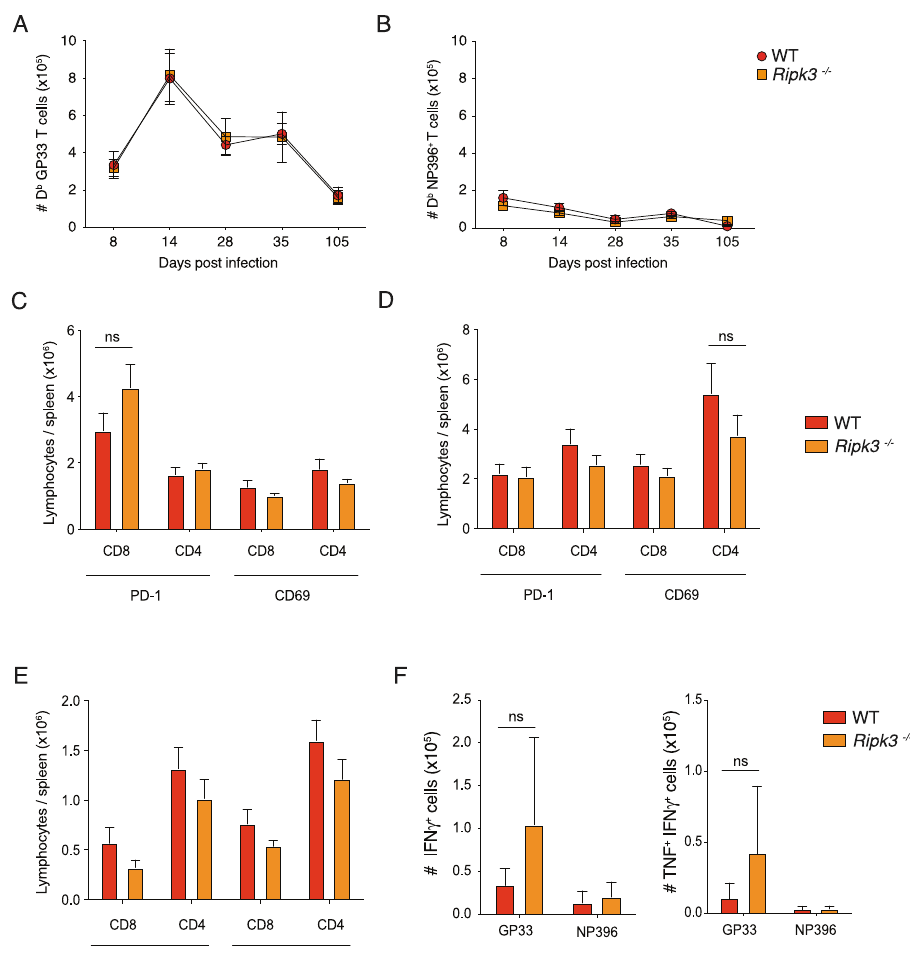
Fig. 4 Loss of RIPK3 does not alter the numbers and activation status of CD8 + T cells responding to infection throughout chronic LCMV infection. A , B Absolute numbers of CD8 + T cells that speci fi cally recognise the LCMV epitopes ( A ) GP33 or ( B ) NP396 from the spleens of WT or RIPK3-de fi cient mice over the course of LCMV docile infection ( n = 8-12). C Absolute numbers CD4 or CD8 cells that express PD-1 or CD69 from the spleens of WT or RIPK3-de fi cient mice 8 days pos-infection with LCMV docile infection ( n = 4). D Absolute numbers CD4 or CD8 cells that express PD-1 or CD69 from the spleens of WT or RIPK3-de fi cient mice 35 days post-infection with LCMV docile infection ( n = 4 per genotype). E Absolute numbers CD4 or CD8 cells that express PD-1 or CD69 from the spleens of WT or RIPK3-de fi cient mice 105 days